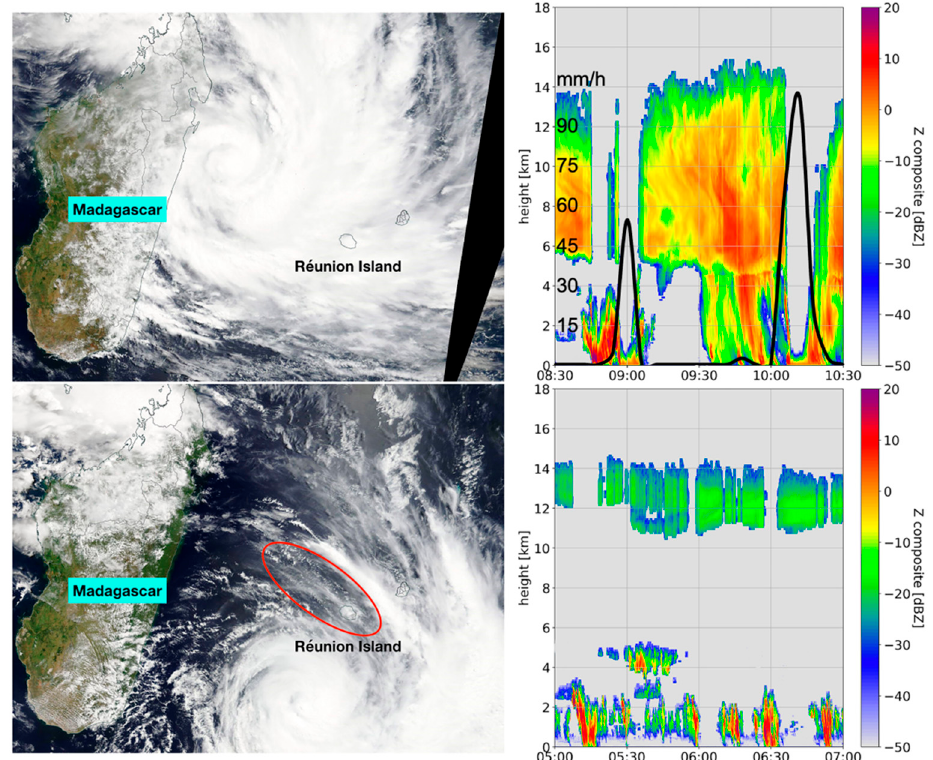
Figure 3. Left panel: Satellite images (MODIS TERRA) of Tropical Cyclone Dumazile, recorded on 4 March 2018 ( top , 9:00 UTC) and 6 March 2018 ( bottom , 6:00 UTC). Right panel: corresponding time series of BASTA ‐ REUNION vertical radar reflectivity profiles (dBZ, UTC) with superimposed collocated rainfall measurements every 6 min (expressed in mmh − 1 , scale to the left). The red circle indicates the cirriform region sampled by the radar on 6 March.